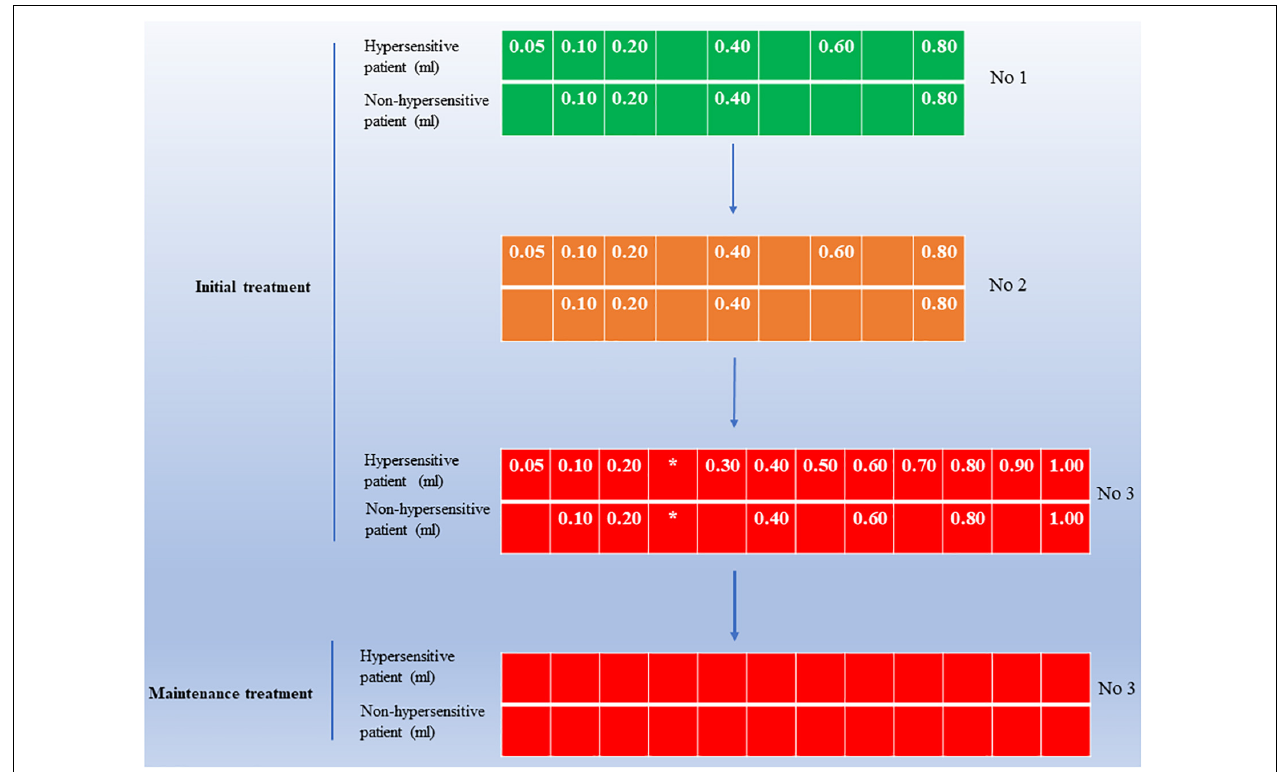
FIGURE 2 | An overview of SCIT administration schedule in pediatric AR patients. The initial treatment size is available in three vials, including concentrations 1, 2, and 3. Initial treatment should start with the lowest dose at the lowest concentration 1 until the patient’s tolerance limit (individual maximum dose) is reached, with an injection interval of 7–14 days during this period. After reaching the maximum dose in the initial phase enter the maintenance phase of treatment, during which the injected dose is the individual maximum dose, with an injection interval of 4–6 weeks. For hypersensitive patients, use the dose shown in the figure for “hypersensitive patients.” *Note the maximum dose for the individual. Maximum dose concentration 3, 1.0 ml; AR, allergic rhinitis; SCIT, subcutaneous